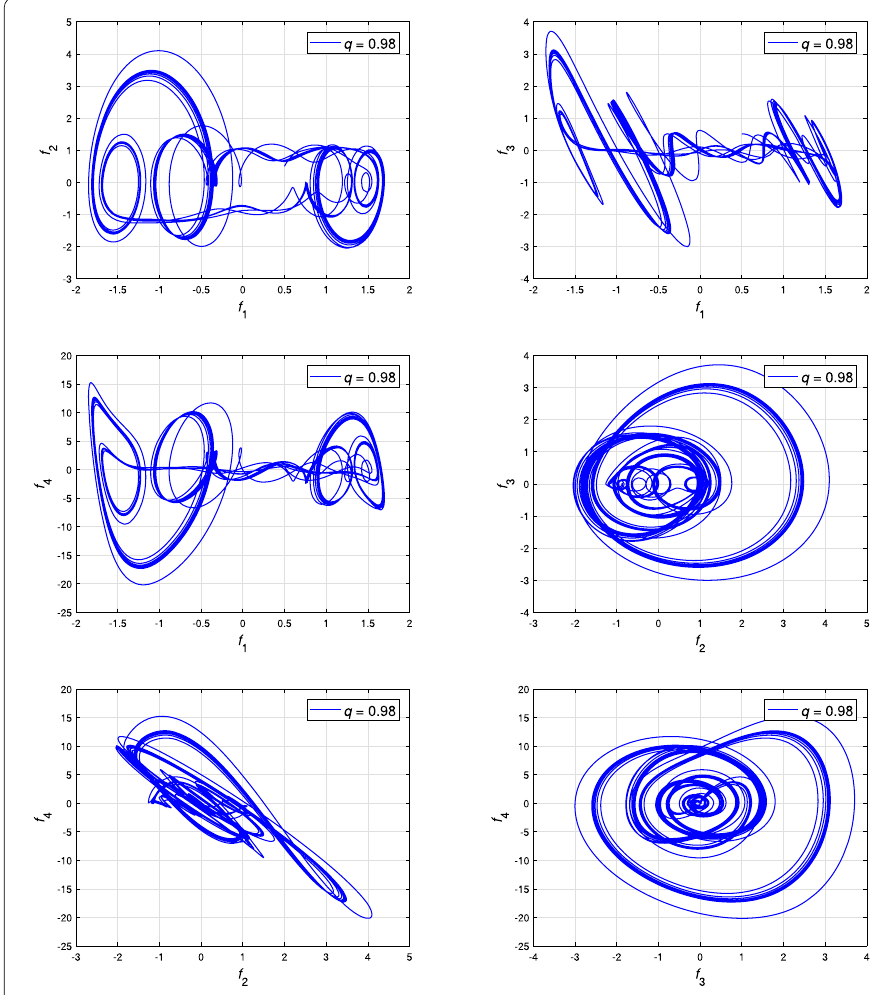
Figure 5 The phase planes of the fractional chaotic system (6) for q =